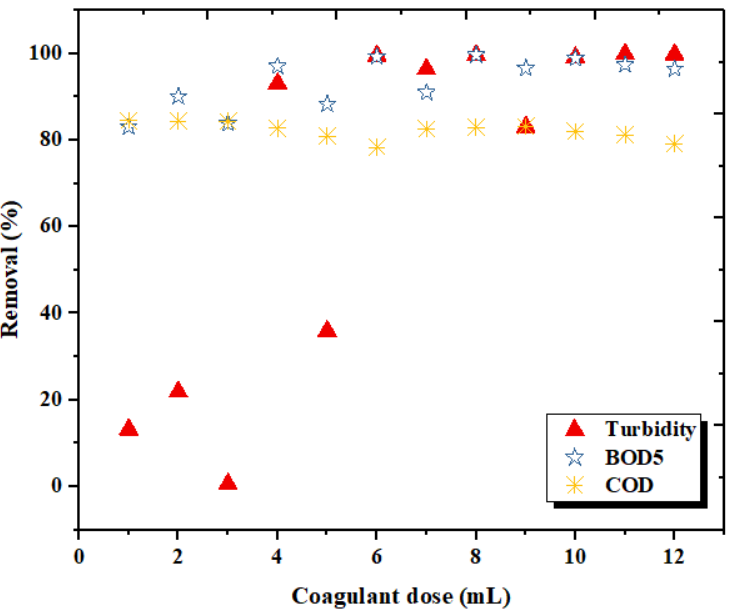
Figure 16. Effect of LC doses on turbidity, BOD 5 and COD removal.